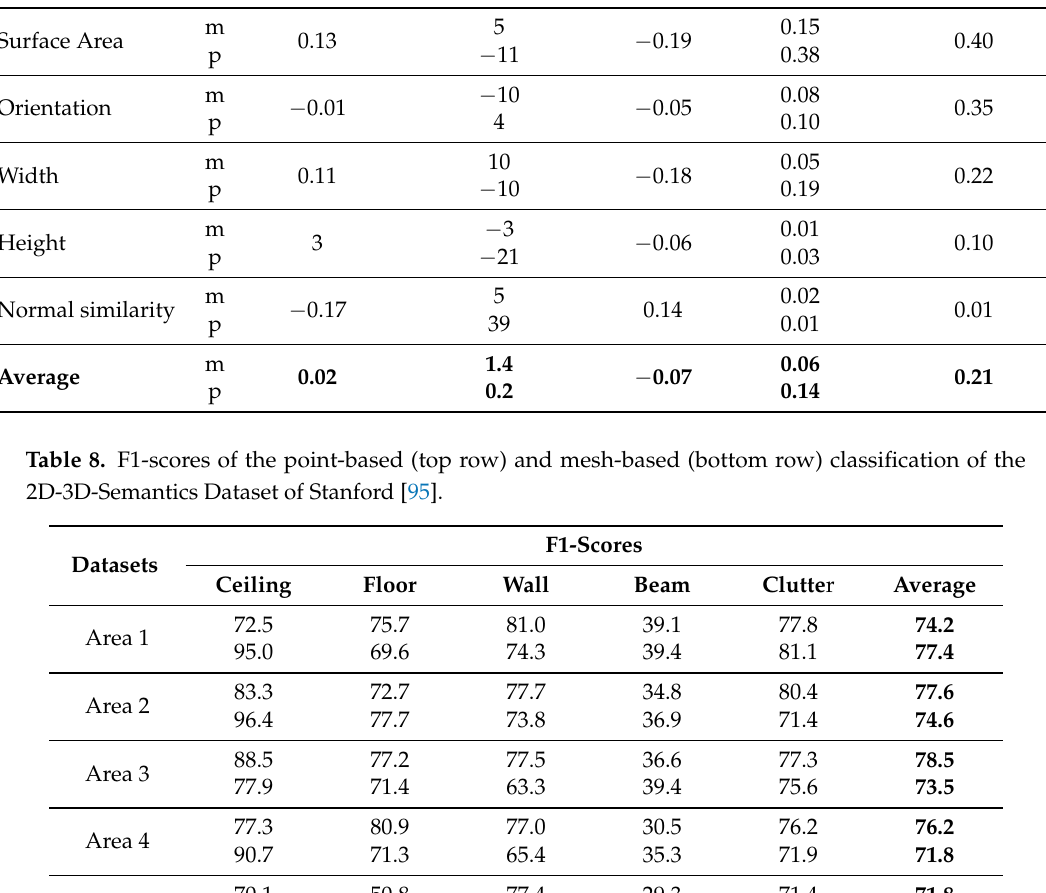
(cid:0) (cid:1) Q 2 ( S m ) − Q 2 ( S p ) is a